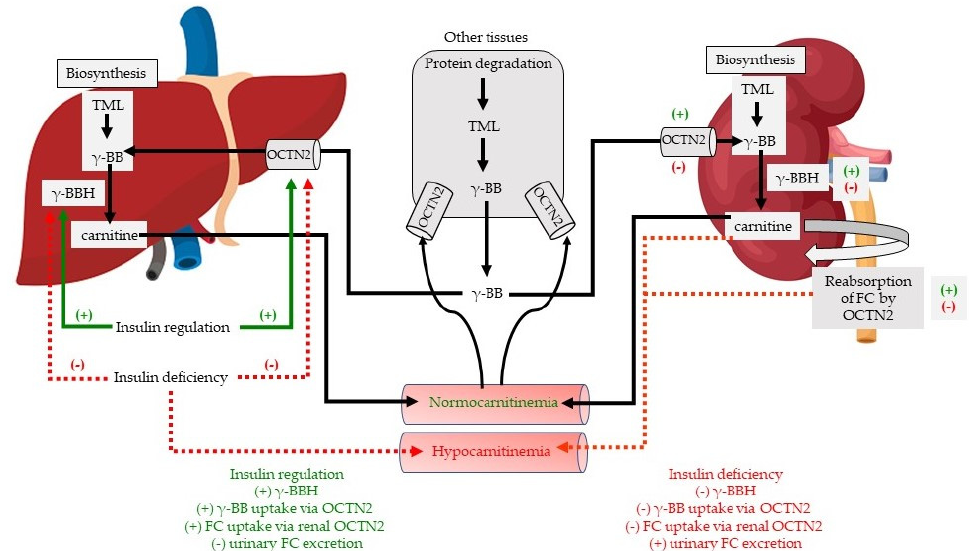
Figure 4. Proposed role of the effects of STZ-induced diabetes and insulin treatment on carnitine homeostasis. Under normal conditions, biosynthesis occurs primarily in the liver and kidney following protein degradation of lysine and methionine to TML [8]. TML is eventually converted to γ -BB. The final reaction in this pathway is the conversion of γ -BB to carnitine by γ -BBH. Carnitine is then released into circulation where it enters tissues against a concentration gradient via the OCTN2 transporter. In tissues that express low γ -BBH function, γ -BB is released into circulation and is actively taken up by the liver and kidney for conversion to carnitine. OCTN2 in kidney promotes reabsorption of FC from urine, thus preventing FC loss. Pancreatic islet β -cell necrosis by STZ results in an insulinopenic state and metabolic aberrations consistent with T1DM. In diabetic rats, we propose that insulinopenia decreases protein expression of γ -BBH and OCTN2 in liver and kidney, resulting in impaired biosynthesis and increased excretion of FC. Low γ -BBH reduces biosynthesis, while low OCTN2 enhances urinary losses of FC, both contributing to hypocarnitinemia. Daily insulin treatment, by stimulating synthesis of these proteins, prevents hypocarnitinemia. FC, free carnitine; γ -BB, gamma butyrobetaine; γ -BBH, gamma-butyrobetaine hydroxylase; OCTN, Na+-dependent organic cation transporter; TML, trimethyllysine; (+), stimulation; ( − ) decreased stimulation.